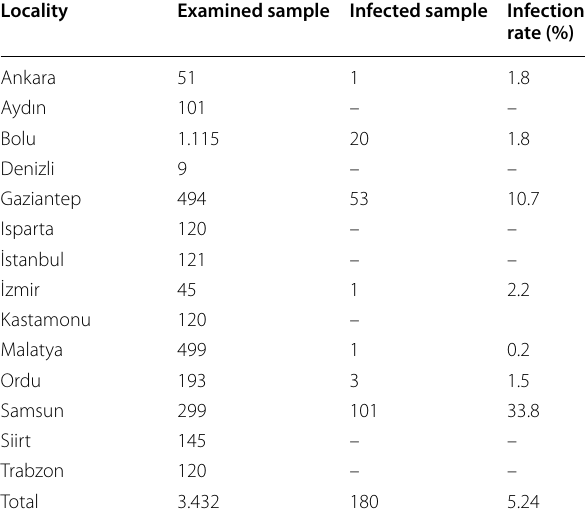
Table 1 Occurrence of Mattesia dispora in Plodia interpunctella populations Locality